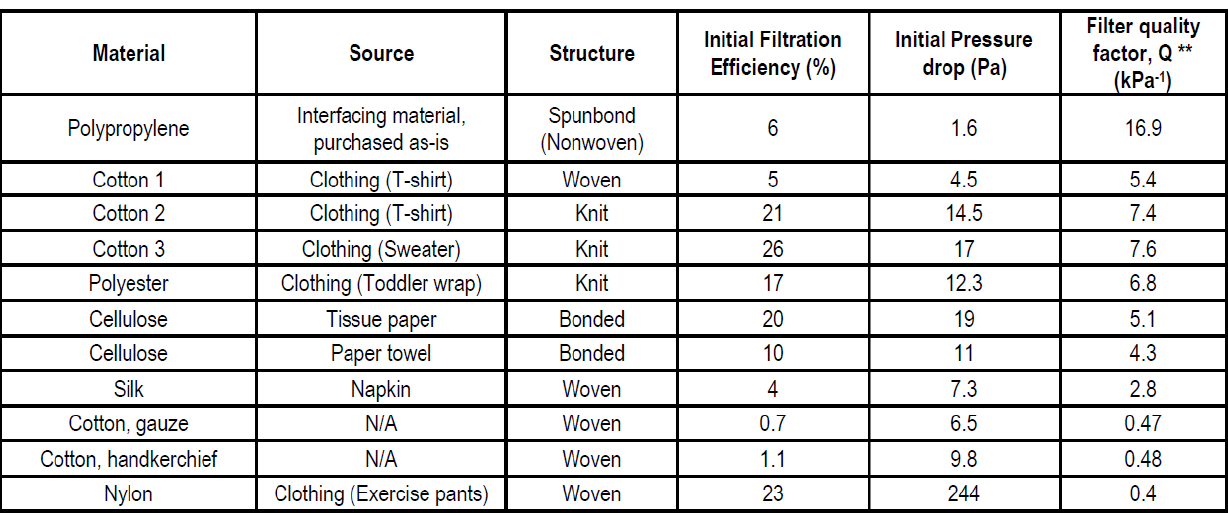
Table 3. Non-medical mask filtration efficiency, pressure drop and filter quality factor* (from the World Health Organization, June 2020 interim guidance “Advise on the use